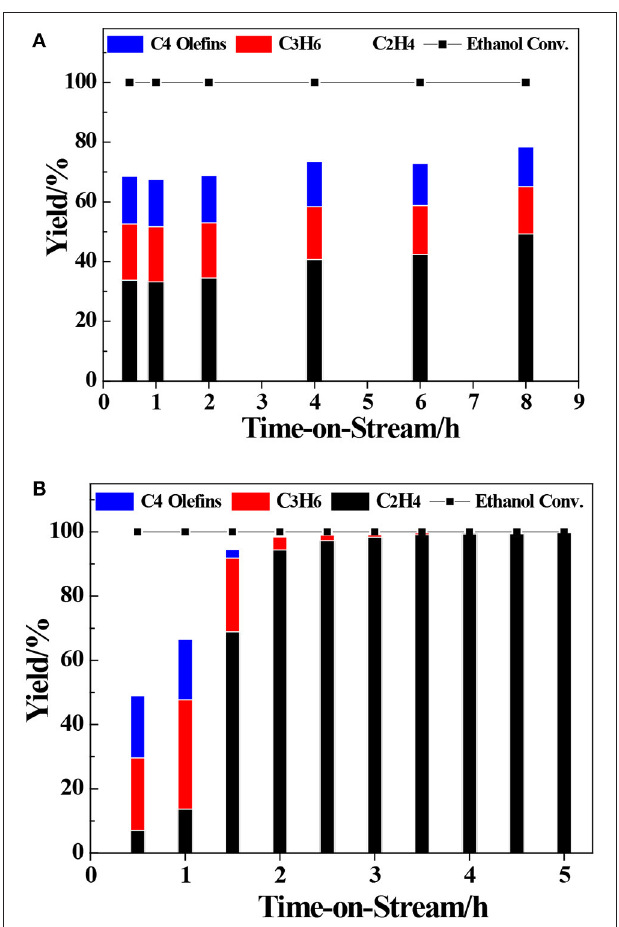
FIGURE 2 | Product distributions of ethanol conversion over ZSM-5 and LEV with time on stream. (A) H-ZSM-5 (40), ( B) H-LEV (40), Reaction conditions: 673K, 0.1 MPa, W/F = 0.05g.min.mL − 1 .